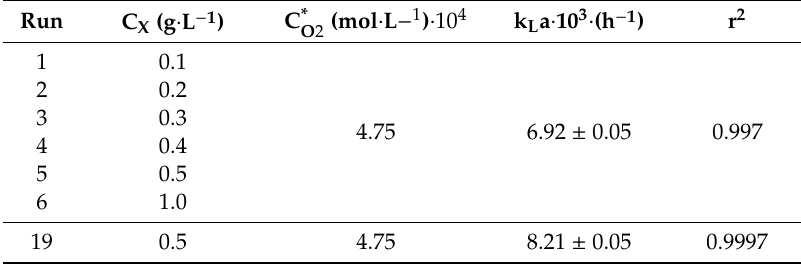
Table 3. Kinetic and statistical parameters calculated for low agitation experiments with mass transfer control of the overall process rate. Runs 1 to 6 (shake flasks) and 19 (STBR).